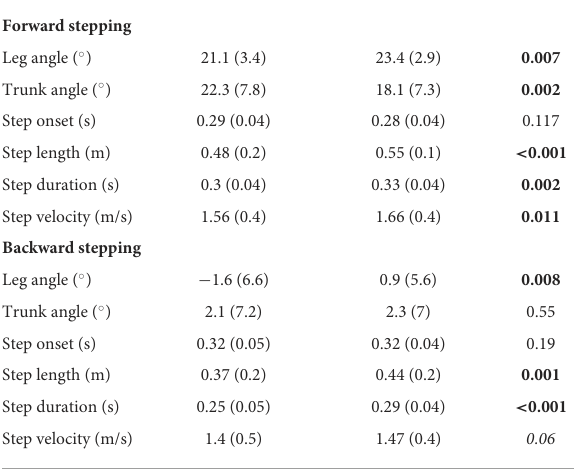
TABLE 2 Mean (SD) pre and post-training values of step quality and step